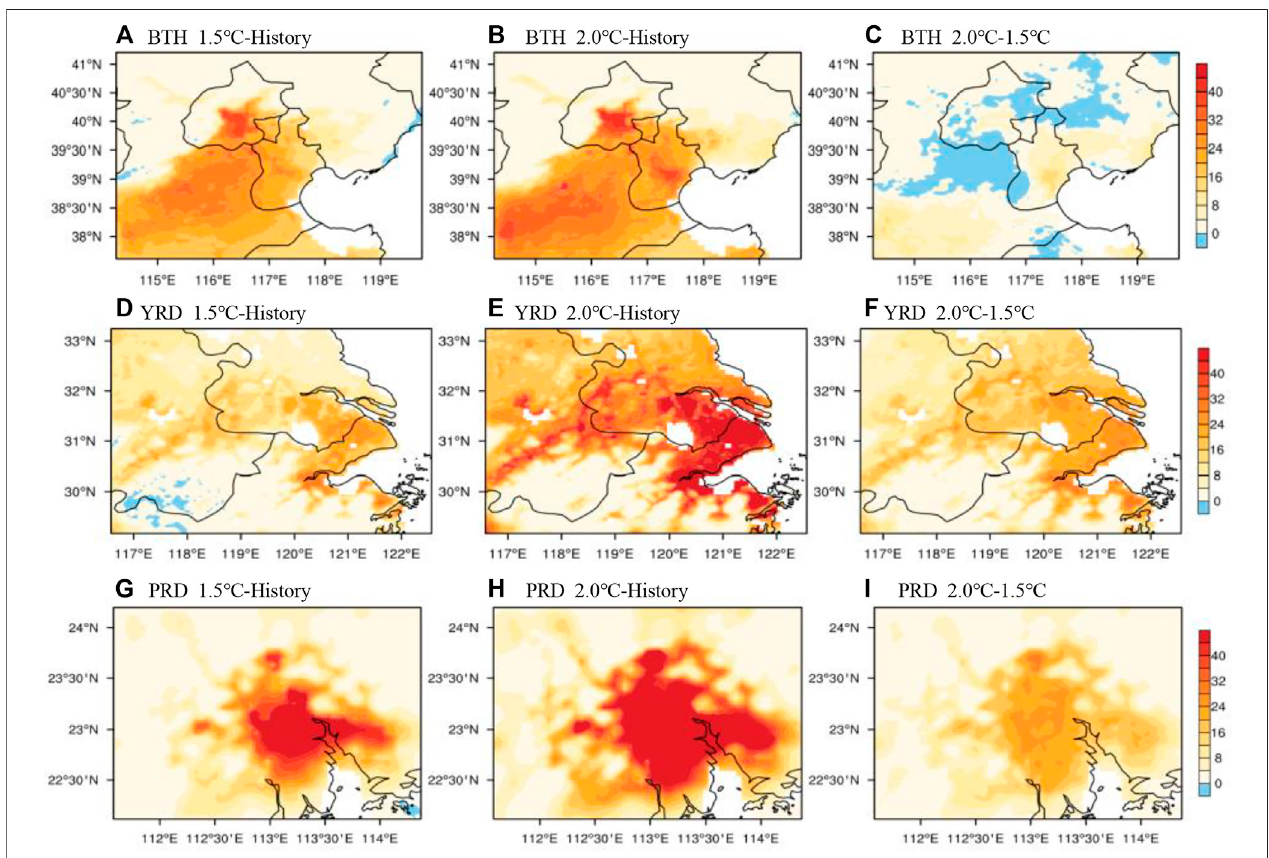
FIGURE8| SpatialdistributionsofthedifferenceinHWintensityoverthethreeurbanagglomerationsbetweenExp1.5-runandExpHIS-run (A,D,G) ,betweenExp 2.0-run and Exp HIS-run (B,E,H) , and between Exp 2.0-run and Exp 1.5-run (C,F,I) . The colored area indicates that the change is statistically signi fi cant at the 95% con fi dence level.